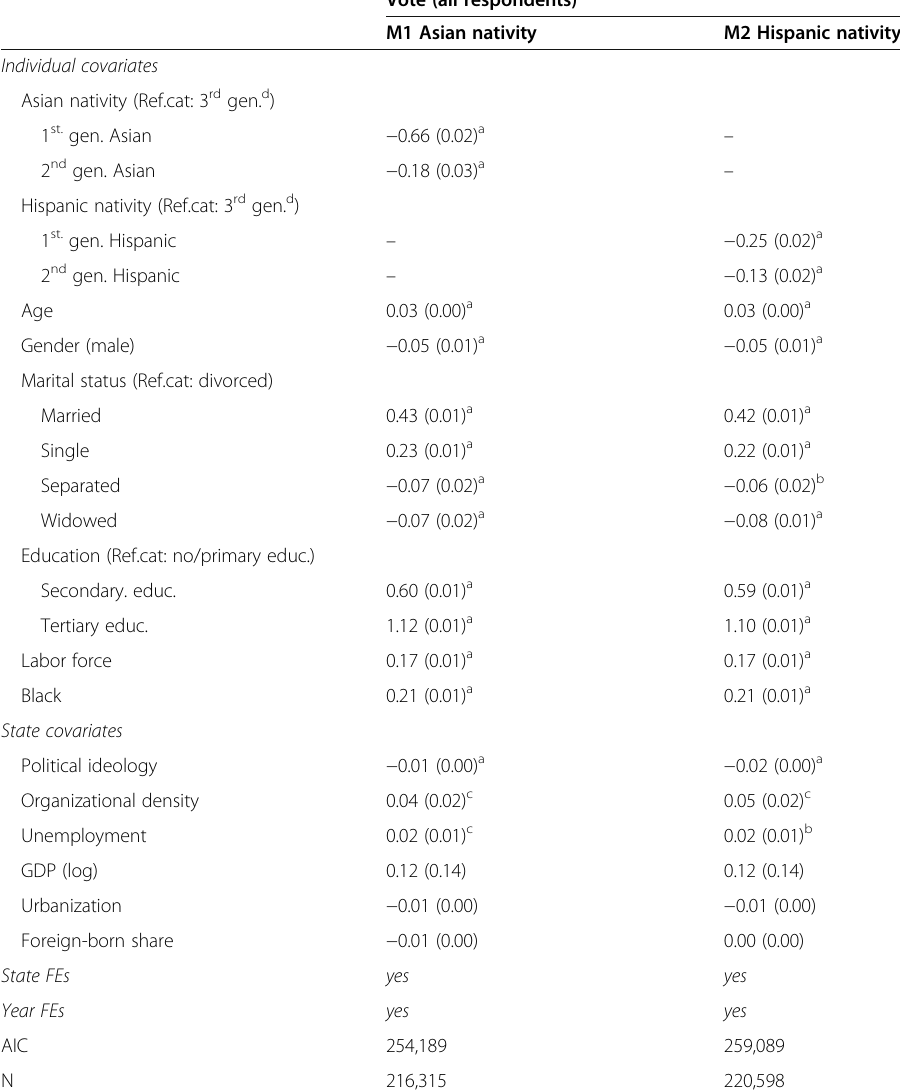
Vote (all respondents) M1 Asian nativity M2 Hispanic nativity